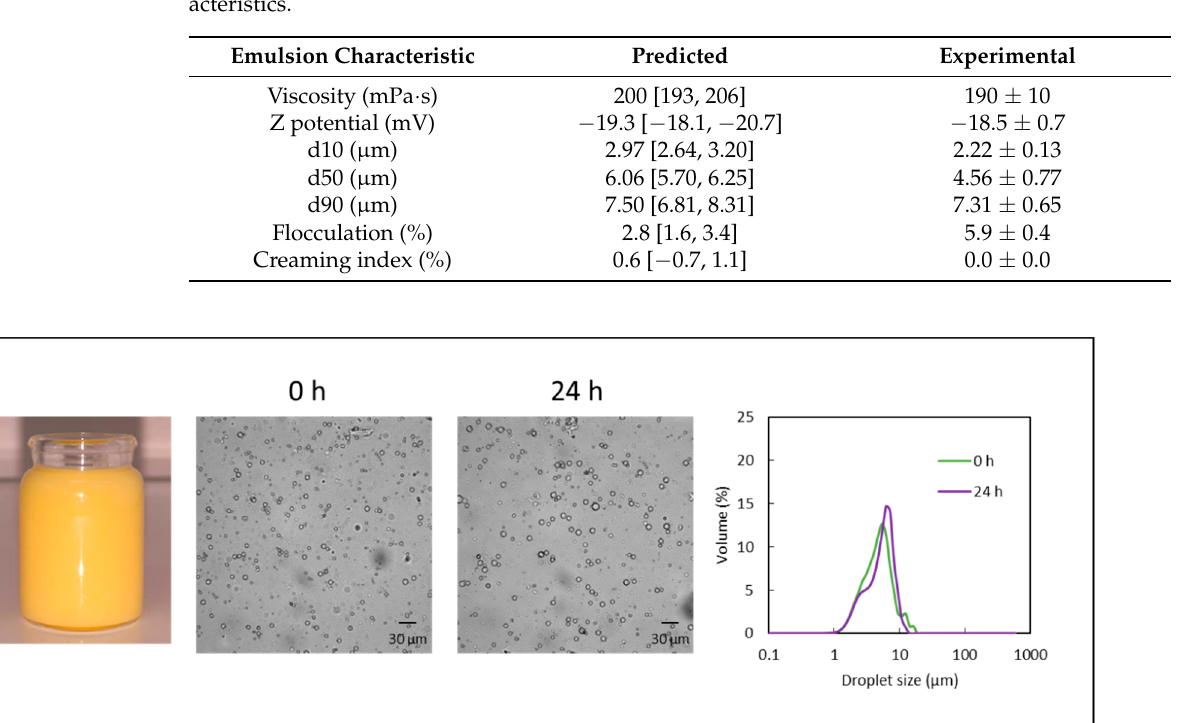
Table 4. Predicted [prediction bounds (95%)] and experimental values of the optimum emulsion characteristics.